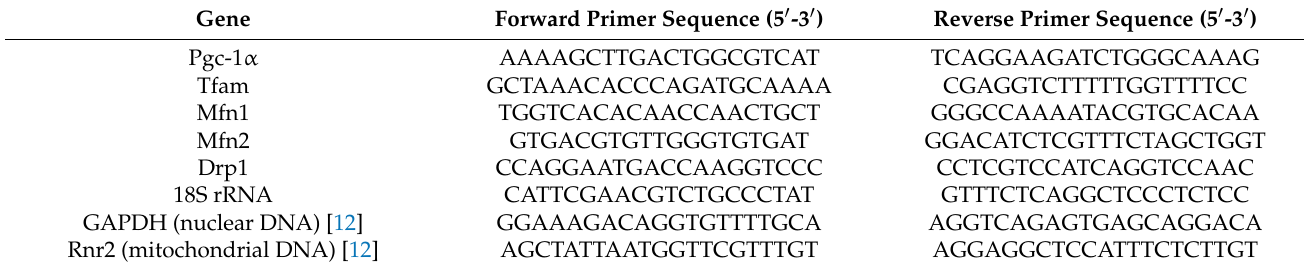
Table 1. PCR primer